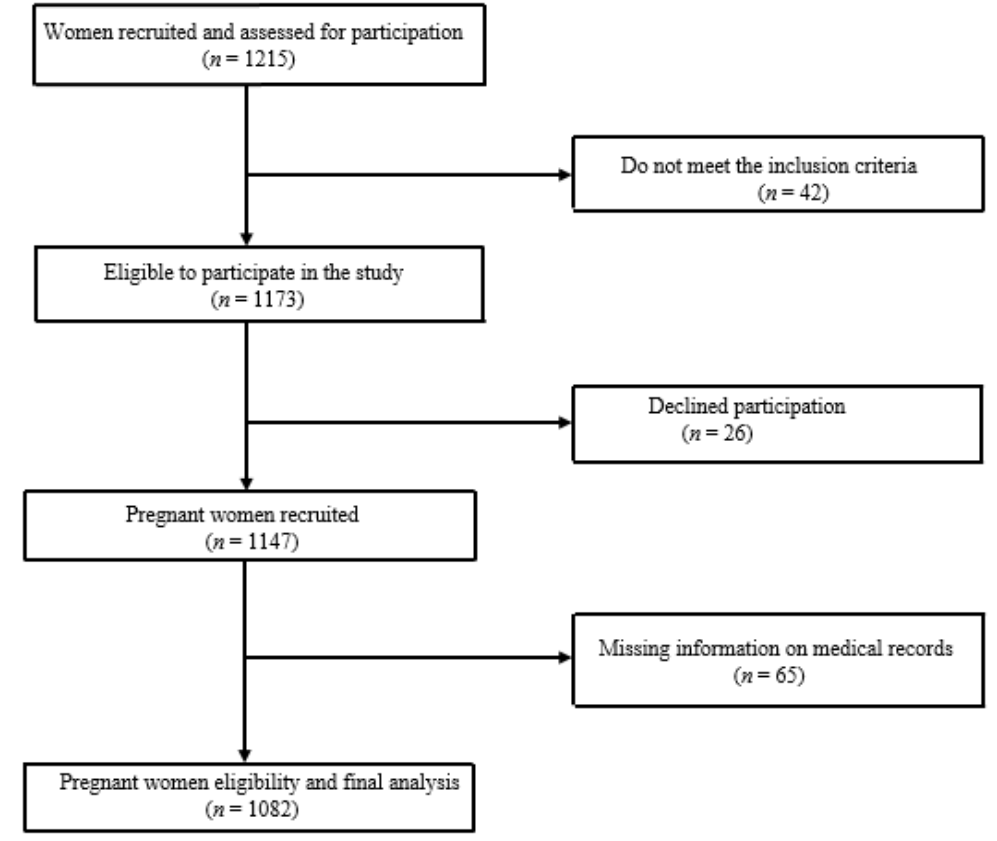
Figure 1. Flow diagram of sample selection and participation.